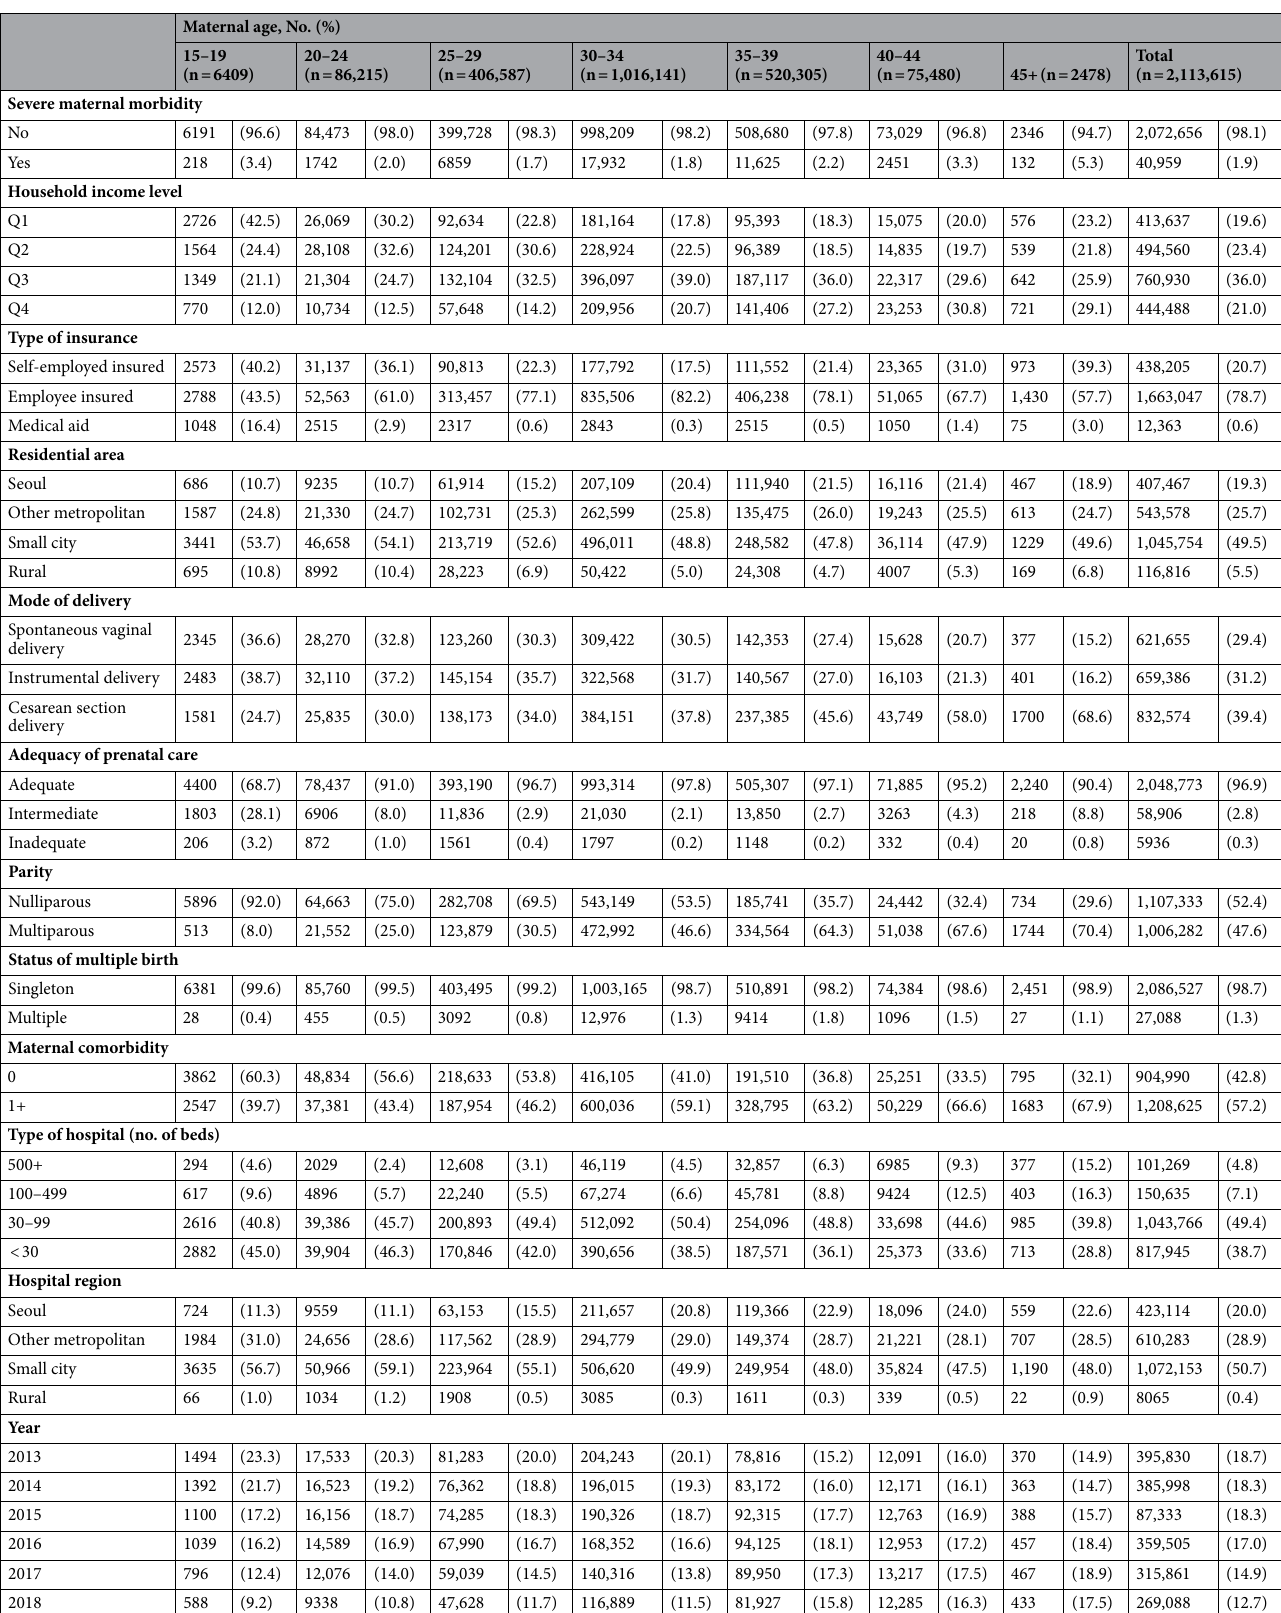
Table 1. General characteristics of study population according to maternal